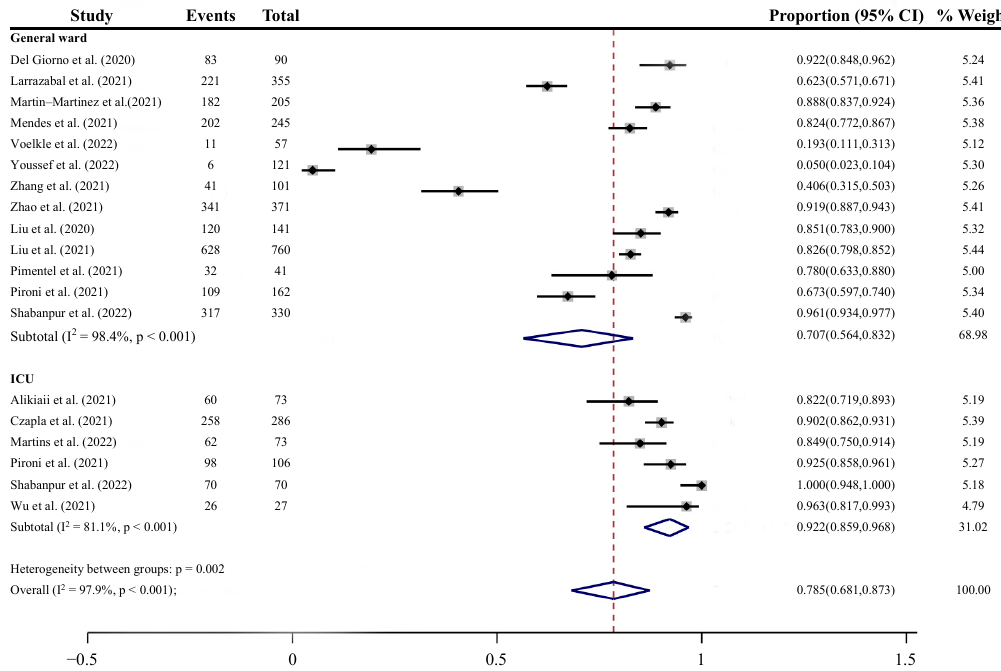
Figure 3. The pooled prevalence of malnutrition in COVID-19 patients [36–52].